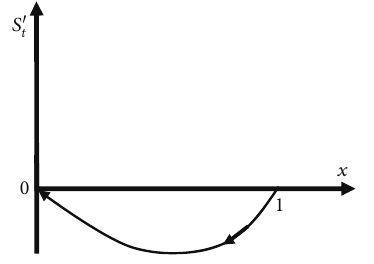
Figure 2: Bank selects the lack of credit